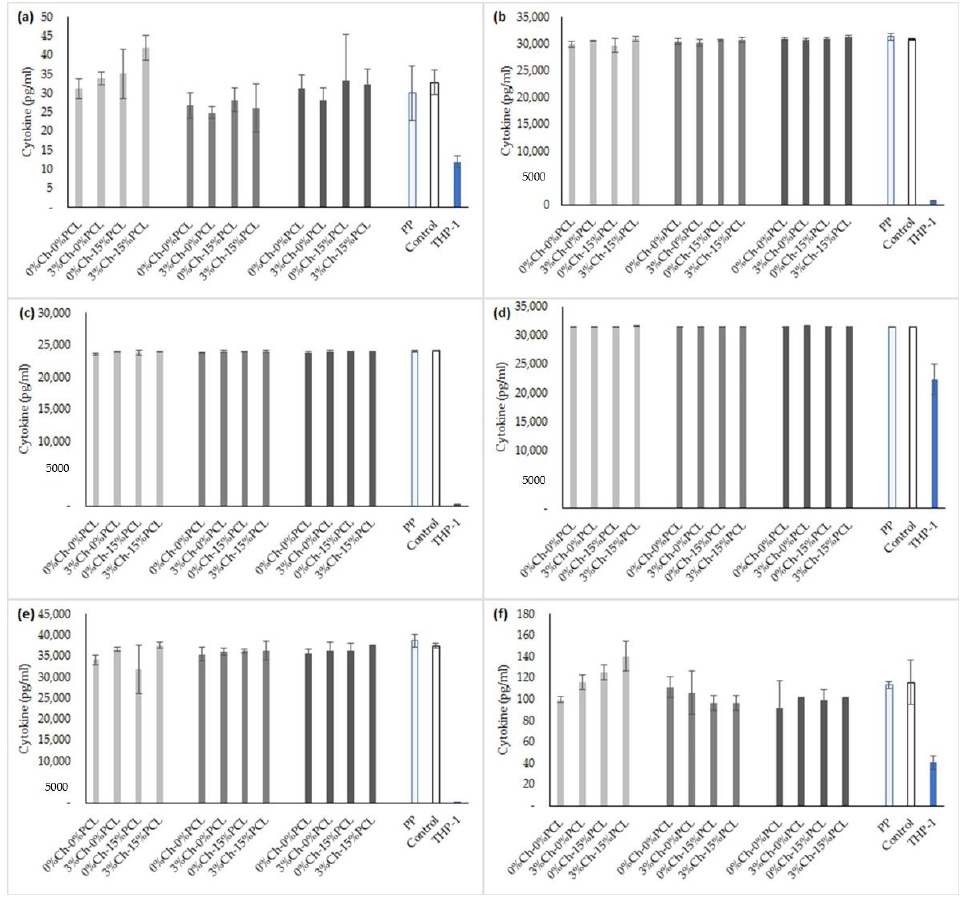
Figure 18. Pro-inflammatory cytokines with LPS stimulation. ( a ) INF-γ; ( b ) TNF-α; ( c ) IL-1β; ( d ) IL-8; ( e ) IL-6; ( f ) IL-2. PP: polypropylene as a reference material; Control: culture medium without PUs; THP-1: monocyte cell line. The concentration of cytokines is expressed as the mean ± SD (n = 3).